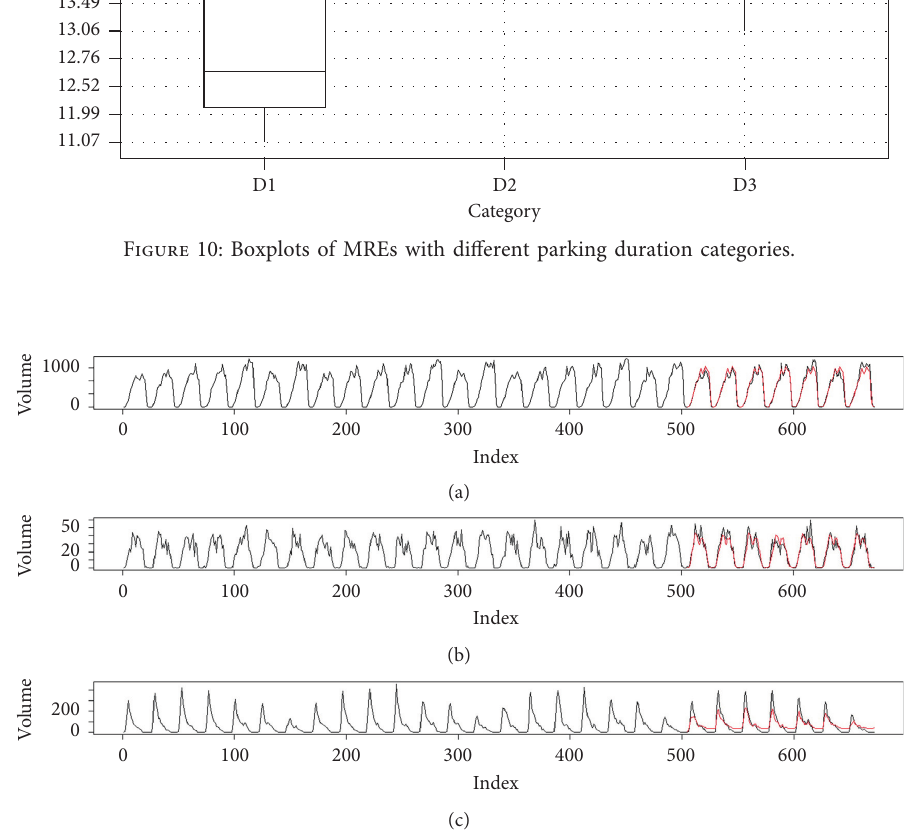
Figure 11: Experiments of the parking volume forecast of categories D1, D2, and D3 by using